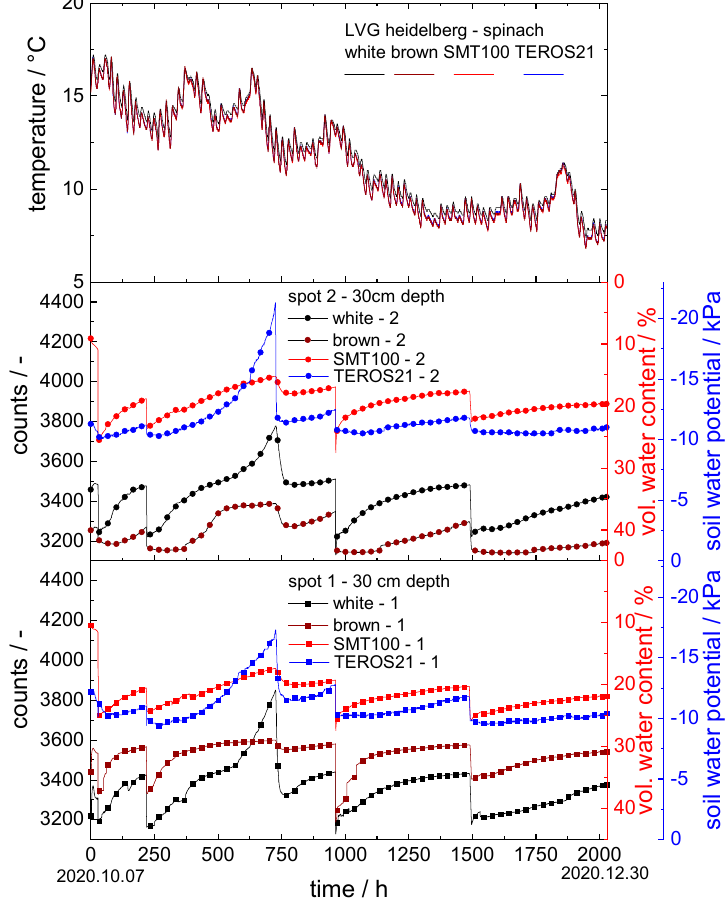
Figure 7. Soil moisture measurement experiment at LVG in spinach research field: the upper graph shows temperature vs. time at all sensor positions; in the middle and lower graphs, counts are plotted vs. time in hours for our new sensors; vol. water content vs. time for the SMT100 and soil water potential vs. time for TEROS 21.